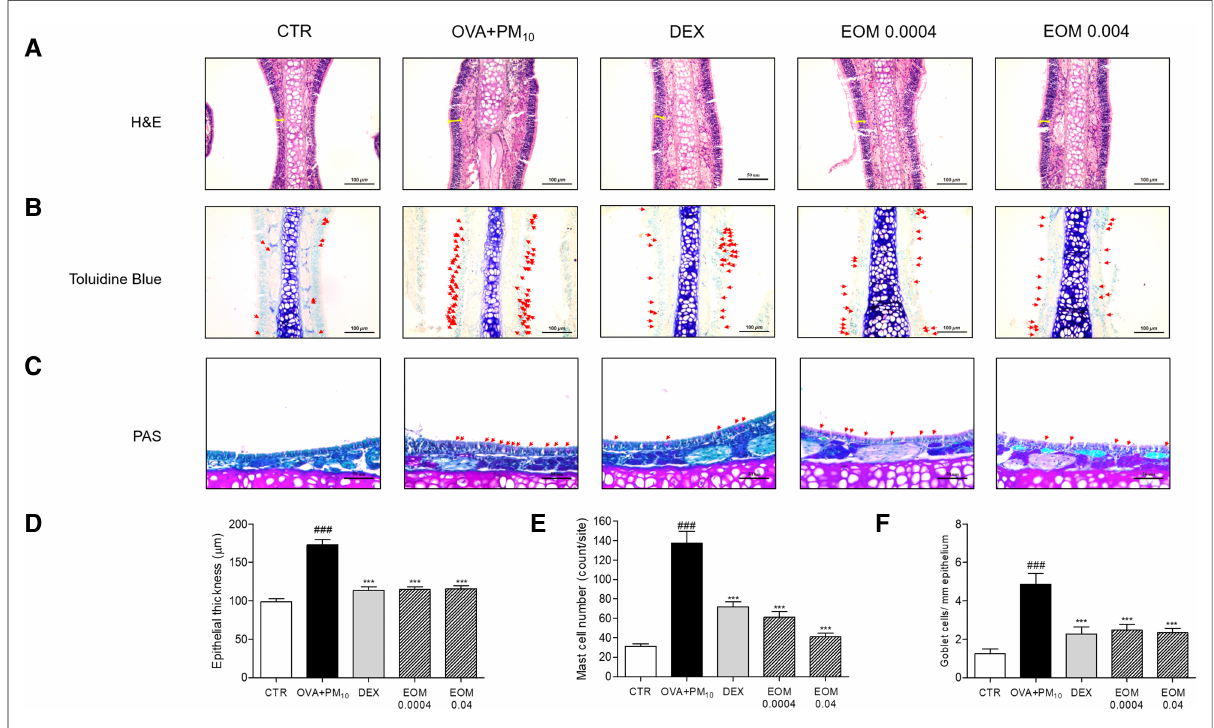
FIGURE 2 The effects of EOM on histopathological changes in nasal septum tissue during OVA and PM10-induced allergic rhinitis mice. The effects of EOM on histopathological changes in trachea tissue during OVA and PM10-induced allergic rhinitis mice. Trachea tissues were stained with hematoxylin and eosin (H&E) ( A ), toluidine blue ( B ), and periodic acid-Schiff (PAS) ( C ) in OVA and PM10-induced mice. Thickness of trachea epithelium ( D ), number of mast cell per site ( E ) and goblet cell number per area ( F ) were shown as relative quanti fi ed values. Results are presented as mean±standard error of the mean. ### p <0.001 vs. CTR group; * p <0.05, ** p <0.01 and *** p <0.001 vs. OVA and PM10-treated group. CTR, control; EOM, essential oils from the Mentha piperita leaf ; OVA,